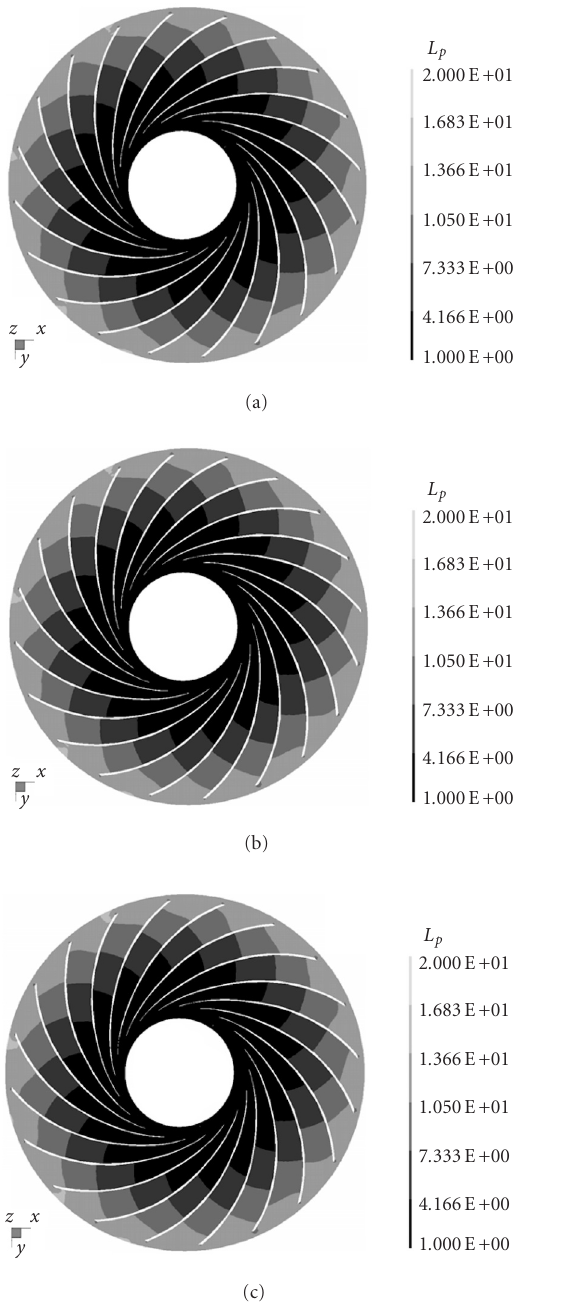
Figure 12: Static pressure distribution on impeller center plane in the vaned di ff user at design conditions: (a) starting position, (b) 1 / 3 revolution, and (c) 2 / 3 revolution.